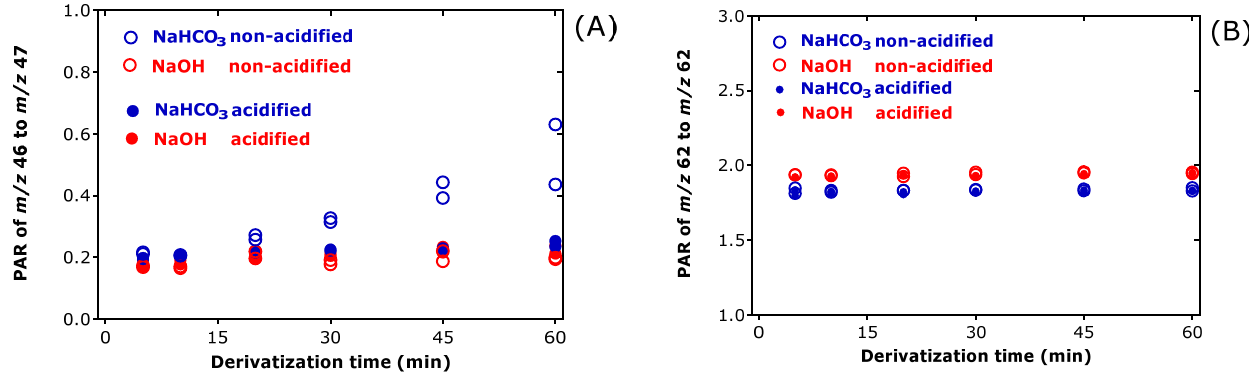
Figure 1. Effects of exogenous NaHCO 3 and NaOH on nitrite and nitrate analysis by GC-MS after derivatization with PFB-Br for the indicated times at 50 °C in a pooled human urine sample treated with 100 mM NaHCO 3 or with 100 mM NaOH. The samples were derivatized before and after acidification with 20 wt.% acetic acid. The concentrations of the internal standards in the urine samples were 400 µM [ 15 N]nitrate and 4 µM [ 15 N]nitrite. Data are shown from two independent experiments. All nitrite and nitrate species were measured simultaneously by GC-MS using selected-ion monitoring of ( A ) m/z 46 for [ 14 N]nitrite and m/z 47 for [ 15 N]nitrite, and of ( B ) m/z 62 for [ 14 N]nitrate and m/z 63 for [ 15 N]nitrate.